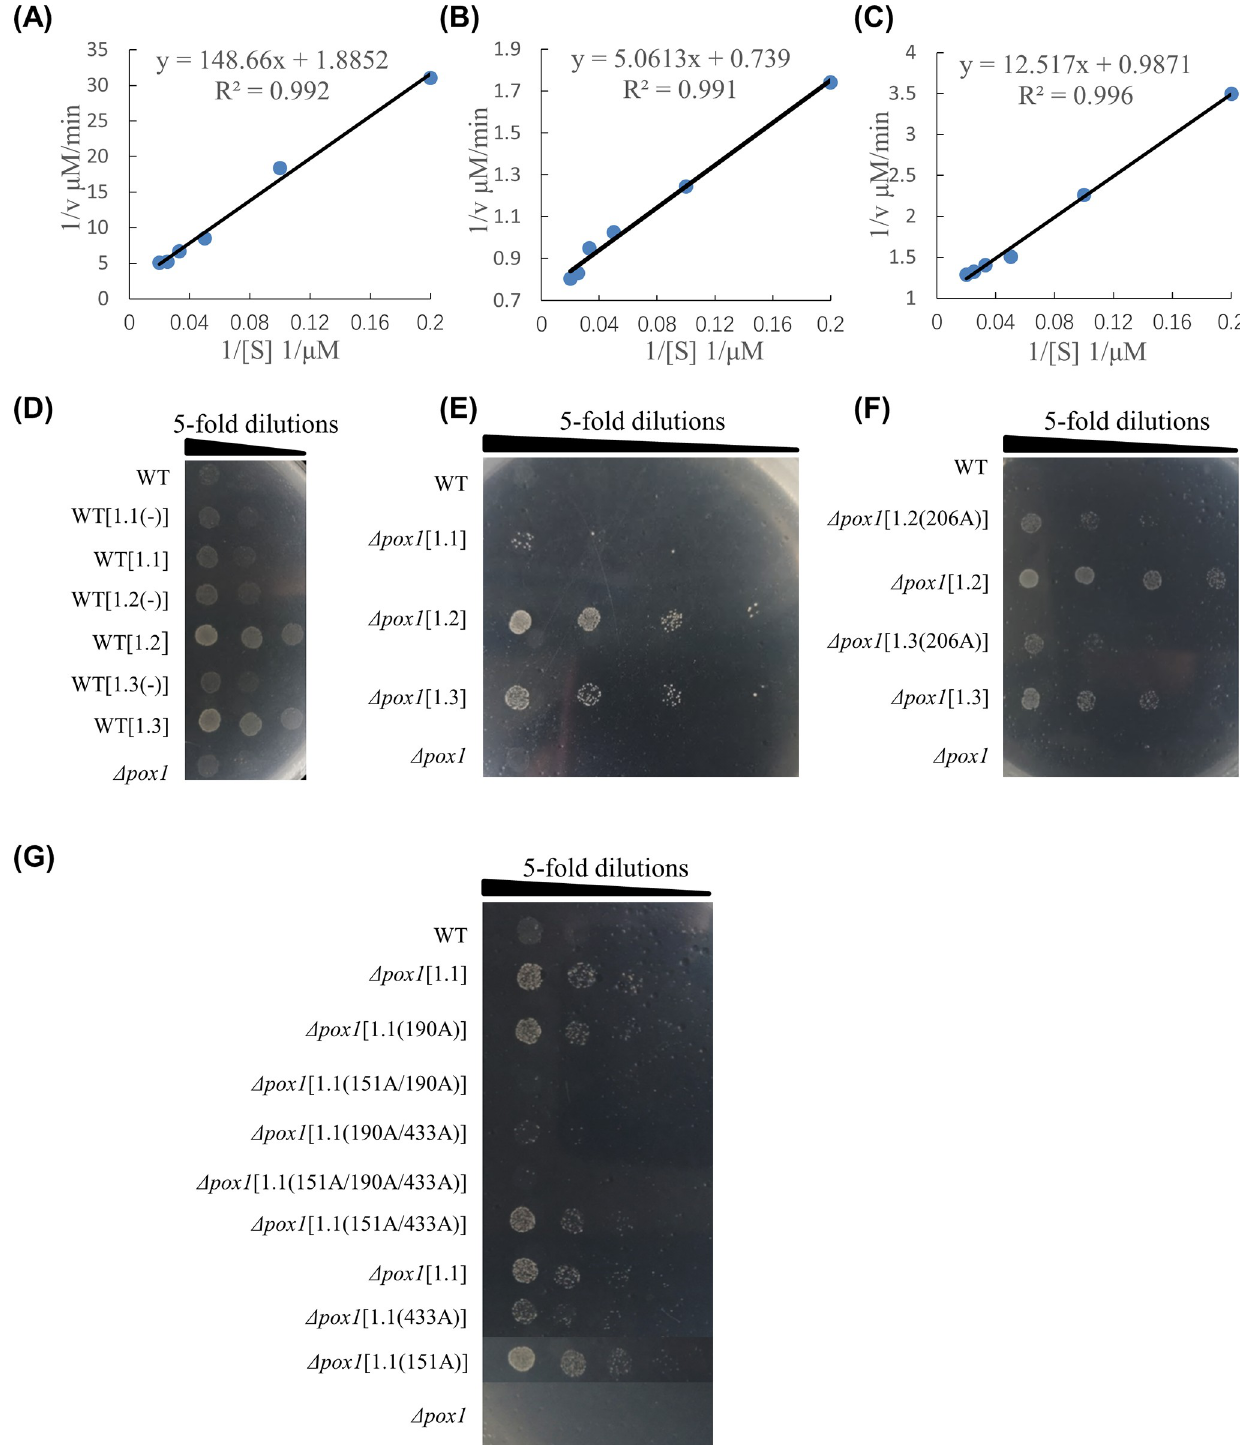
Fig 2. Enzyme activity and spotting assay of Hc -ACOX-1 in vivo and in vitro . (A-C) Linear double-reciprocal plots of Hc -ACOX-1.1 (A), Hc -ACOX-1.2 (B) and Hc -ACOX-1.3 (C) constructed based on reciprocal reaction velocity (1/V) and reciprocal value of palmitoyl-CoA concentration (1/[S]). Panels D-G: The letters (1.1, 1.2 and 1.3) in square brackets represent the corresponding protein of Hc -ACOX-1 and the characters in parentheses indicate the key sites that are replaced with Alanine. 151A/190A represents the 151st and 190th amino acids are replaced with Alanine. Yeast concentrations are marked at top with a starting concentration of OD 600 = 1. (D) Growth of wild-type Saccharomyces cerevisiae on YNBO plates (YNB supplemented with oleic acid as